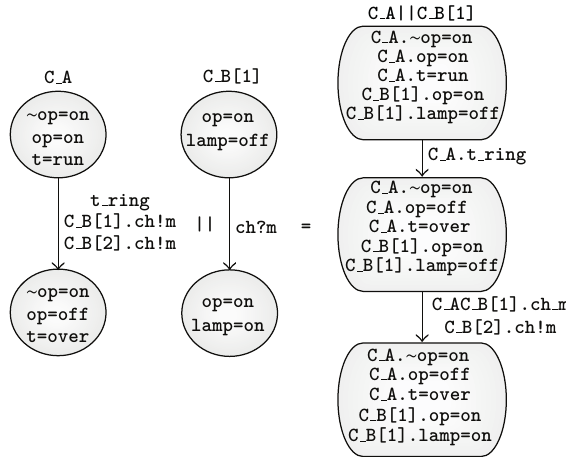
Figure 8: An example transition composition for 𝐶 𝐴 and 𝐶 𝐵[1]